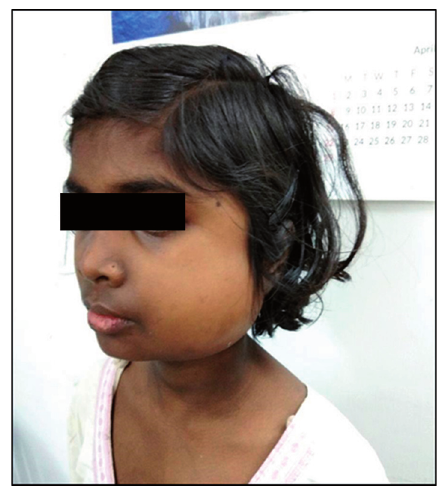
Figure 1: Left parotid region swelling in a 10-year-old girl.